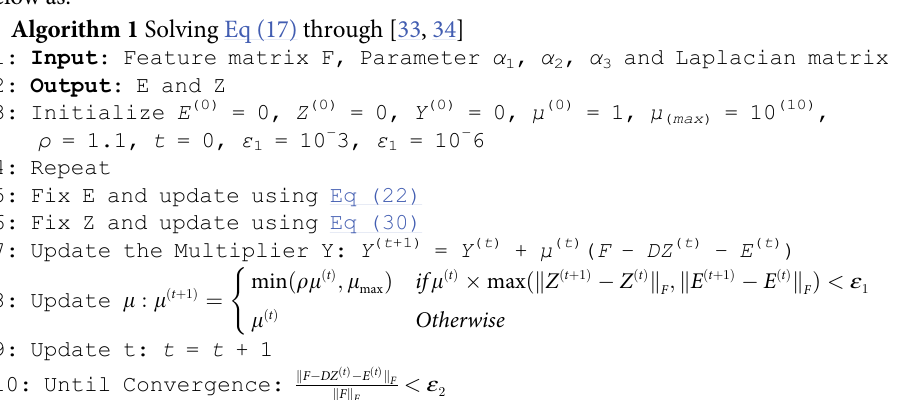
Algorithm 1 Solving Eq (17) through [33,